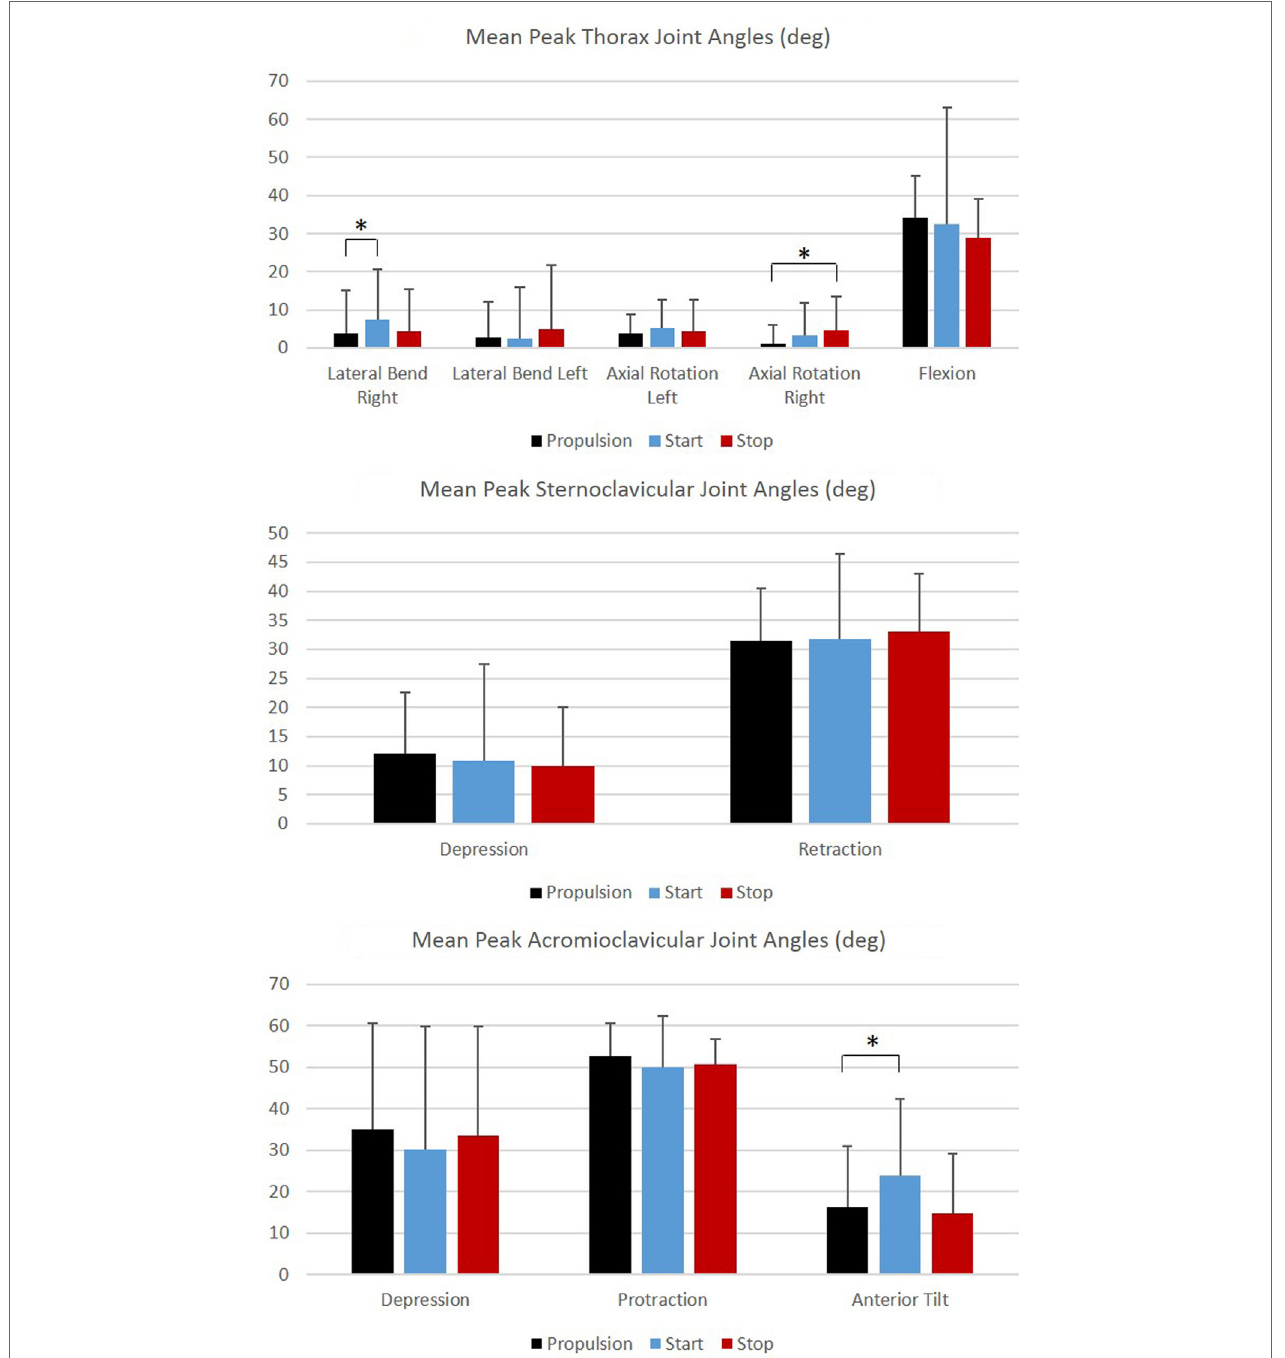
FigUre 5 | group mean peak joint angles (degrees) for the thorax, sternoclavicular, and acromioclavicular joints during each functional mobility task, propulsion (black), start (blue), and stop (red) . One SD is represented by the thin vertical bar. Tasks connected by an asterisk are statistically significantly different ( p <